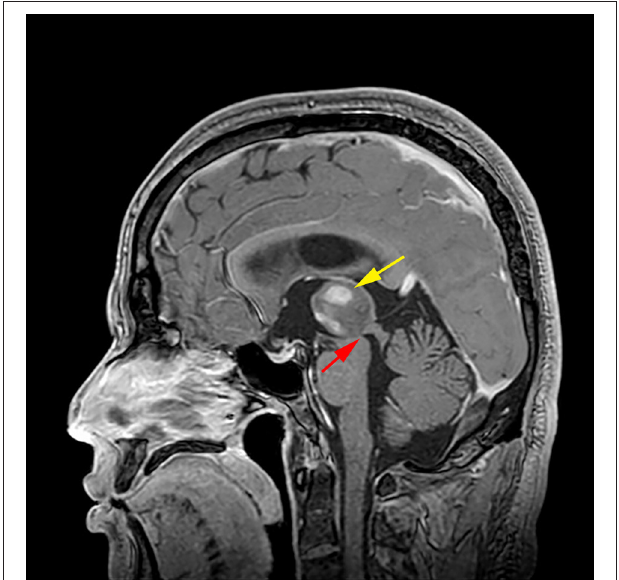
FIGURE 6 | Mechanism of hydrocephalus caused by thalamic glioma. The right thalamic tumor ( indicated) led to stenosis of the upper mouth of the midbrain aqueduct ( indicated), and the circulation of the hydrocephalus is blocked, resulting in obstructive